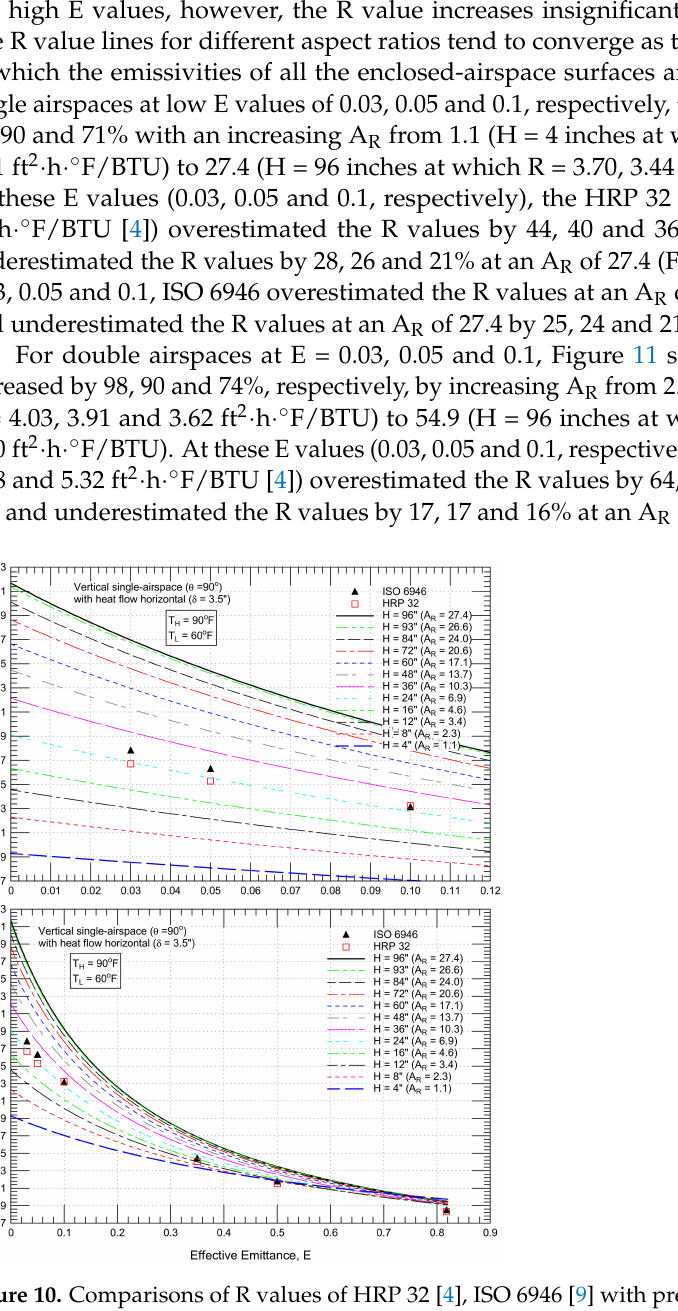
Figure 10. Comparisons of R values of HRP 32 [4], ISO 6946 [9] with present model predictions of various A R for a single airspace subjected to a horizontal heat flow ( θ = 90 ◦ , total δ = 3.5 inches, T H = 90 ◦ F, T L = 60 ◦